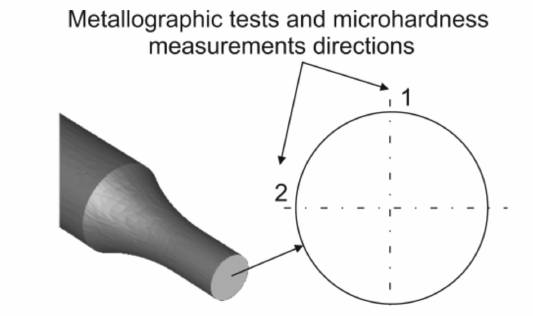
Figure 15. Cross-section of the sample with marked directions in which metallographic tests and microhardness measurements were carried out (general